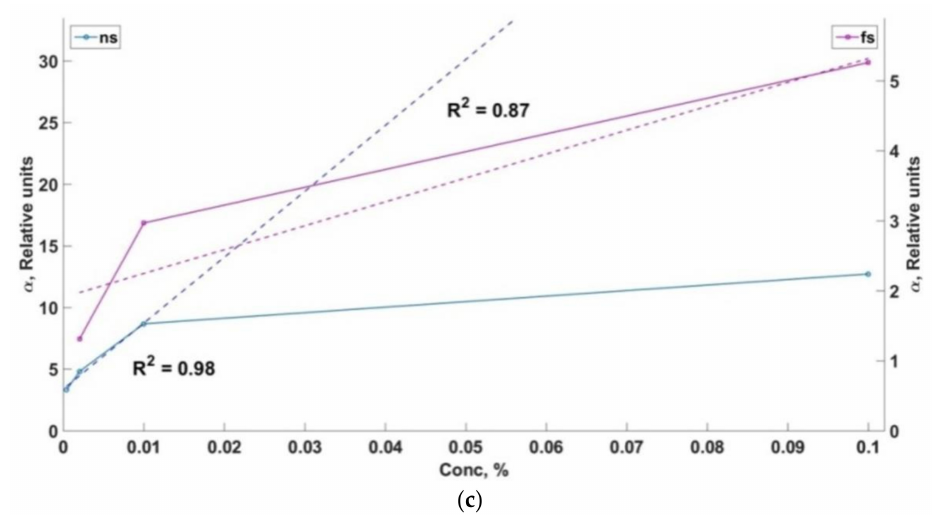
Figure 7. Calibrate functions. ( a ) Calibrate function of crude oil solution; ( b ) Calibrate function of RMB (Residual Marine B)-30; ( c ) Calibrate function of DMA (Distillate Marine). The value of α parameter is laid off on the vertical axis (left one is for nanosecond laser pulses and wright one is for femtosecond laser pulses). The concentration of the oil products solution (%) is shown on the horizontal axis. The coefficient of determination R 2 corresponds to the approximation function marked by the dash line.